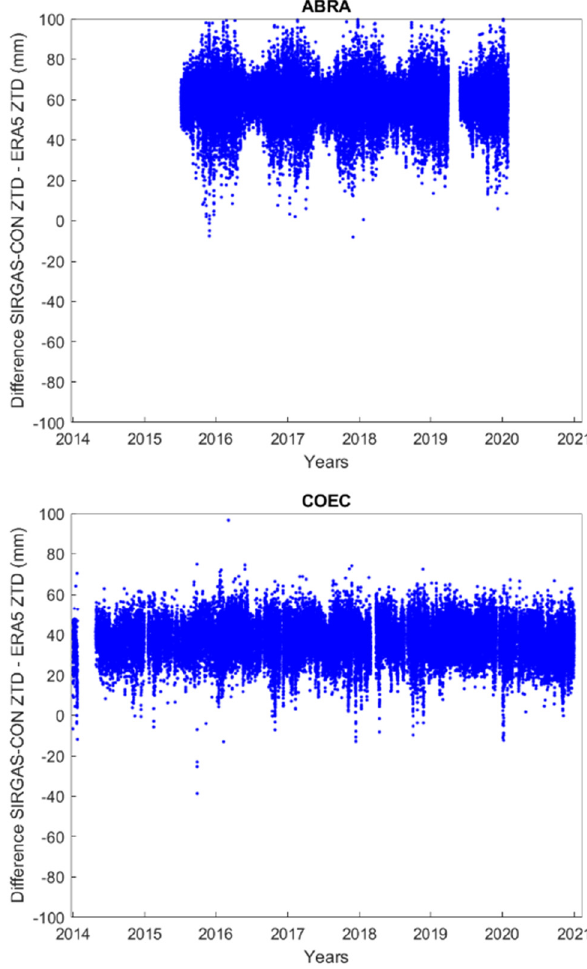
Figure 4: SIRGAS - CON ZTD and ERA5 ZTD di ff erences for stations ( a ) ABRA, with a mean of59mm and standard deviation of11mm, and ( b ) COEC, with a mean of 37mm and standard deviation of